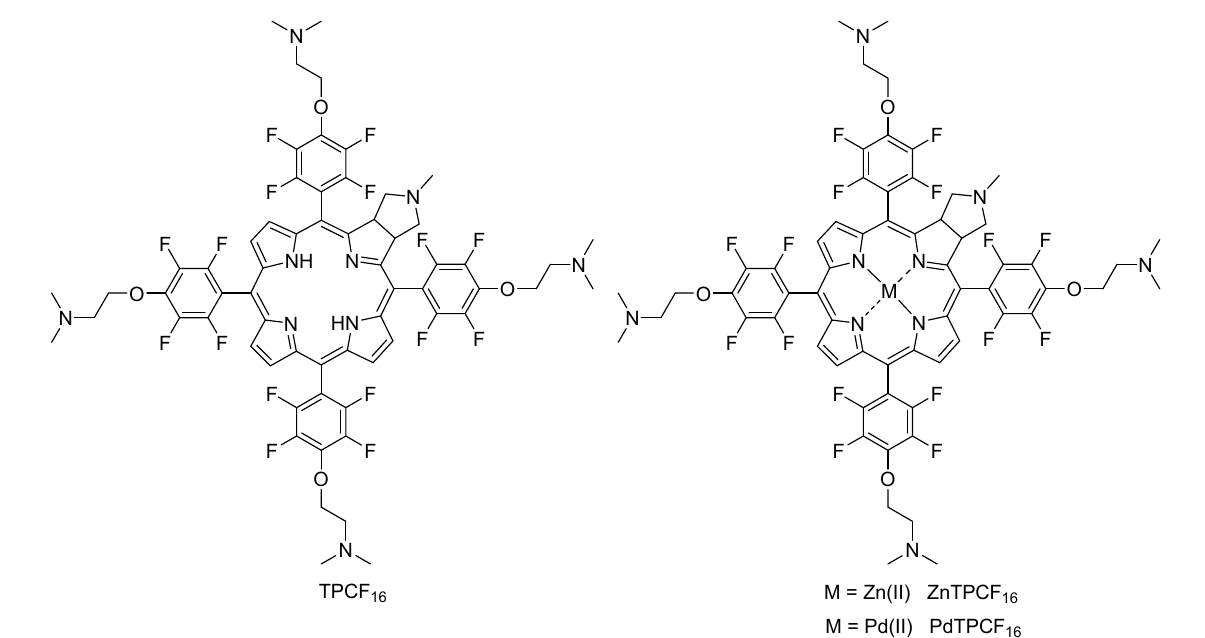
Figure 1. Molecular structure of TPCF 16 and its complexes with Zn(II) and Pd(II).